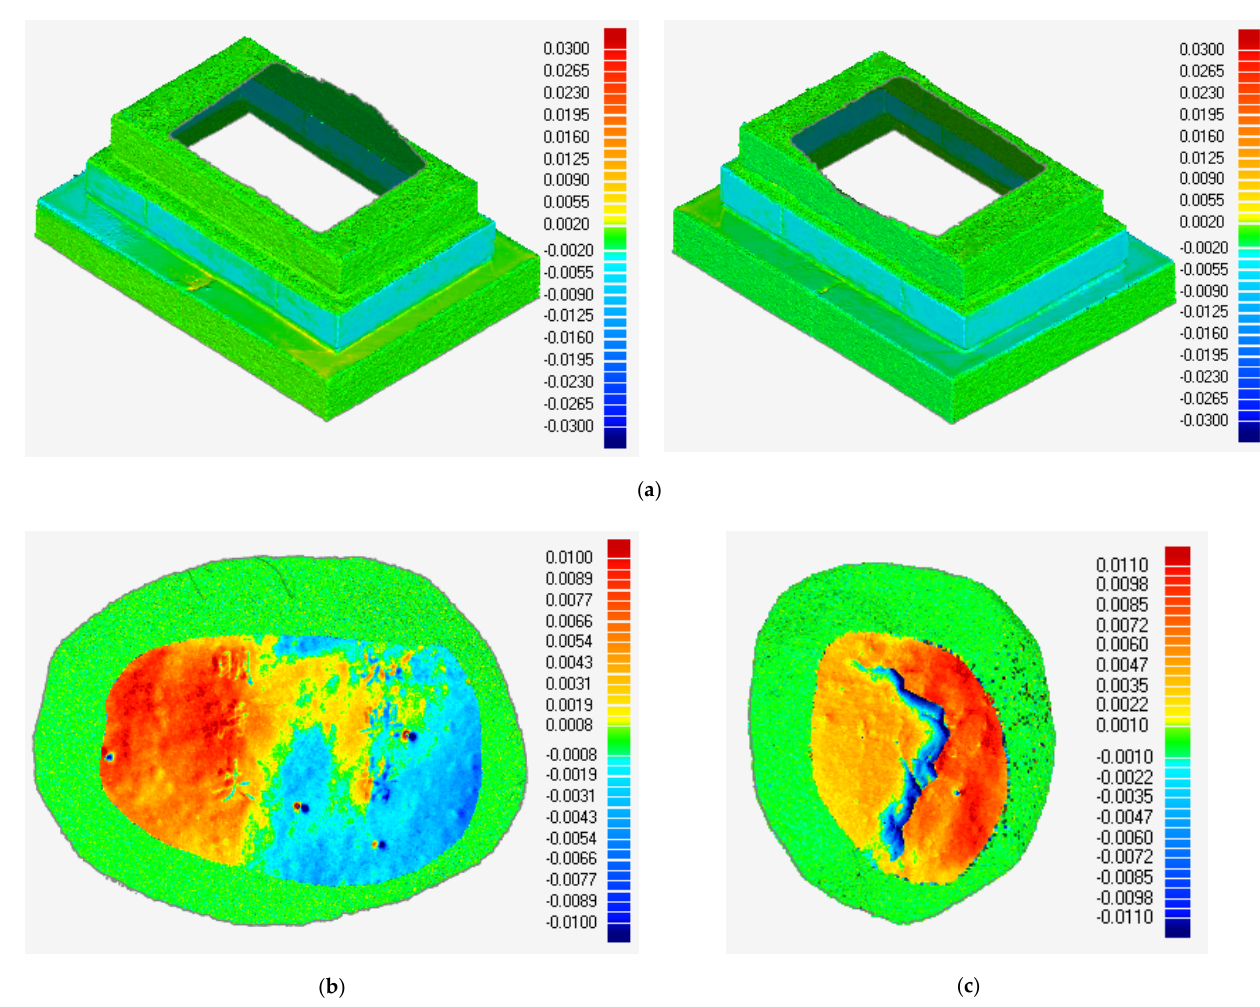
Figure 11. Deviation analysis results of each experimental data: ( a ) Deviation analysis of statue; ( b ) Deviation analysis of S-LS; ( c ) Deviation analysis of NS-LS. Table 15. Deviation analysis values of each experimental data.